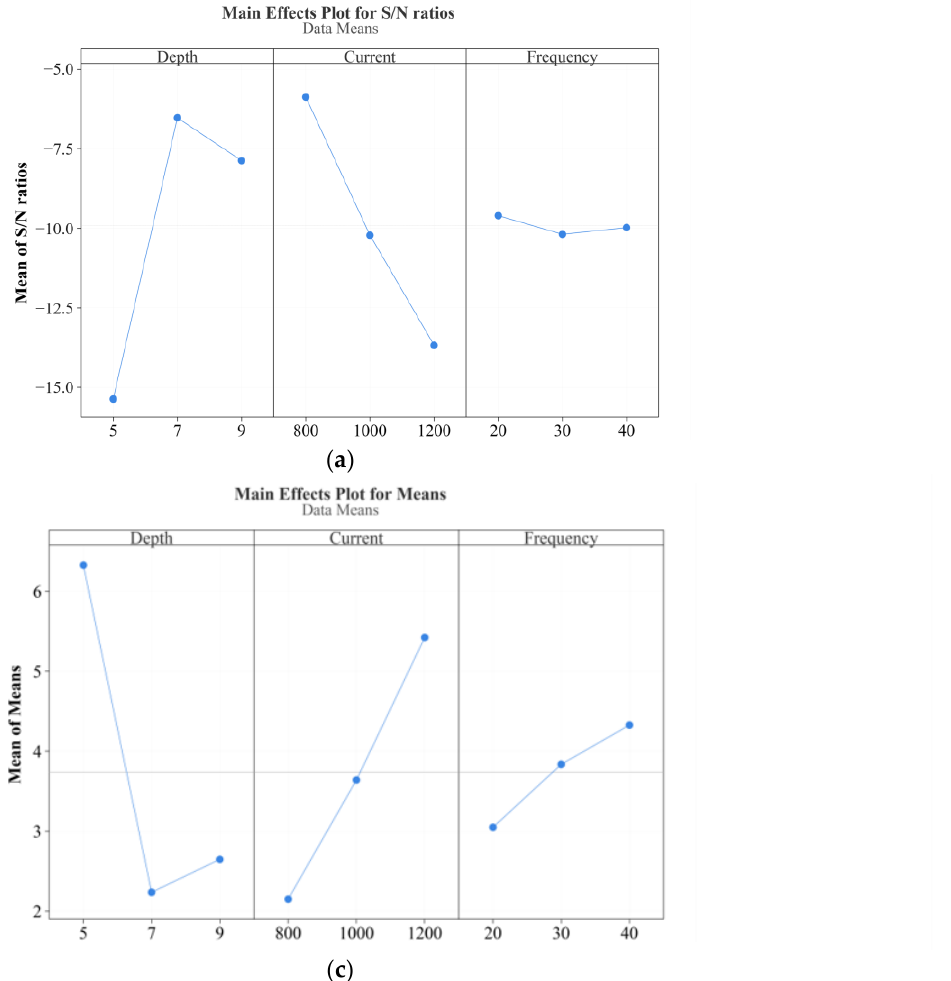
Figure 4. Main effects plots in the Taguchi experiment: ( a ) main effects plot for S/N ratios of three factors in respect of temperature uniformity; ( b ) main effects plot for S/N ratios of three factors in respect of max. mean temperature; ( c ) main effects plot for means of three factors in respect of temperature uniformity; ( d ) main effects plot for means of three factors in respect of max. mean temperature.